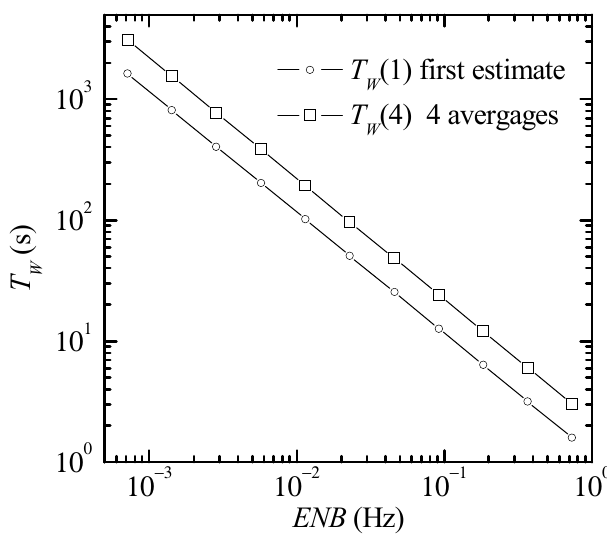
Figure 7. Measurement time for obtaining the first spectra estimation ( T W (1)) and for reaching four averages ( T W (4)) when using QLSA in NB mode vs. the selected ENB.